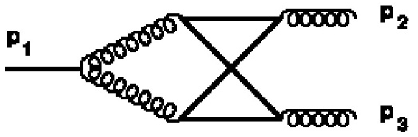
Figure 5. Non-planar